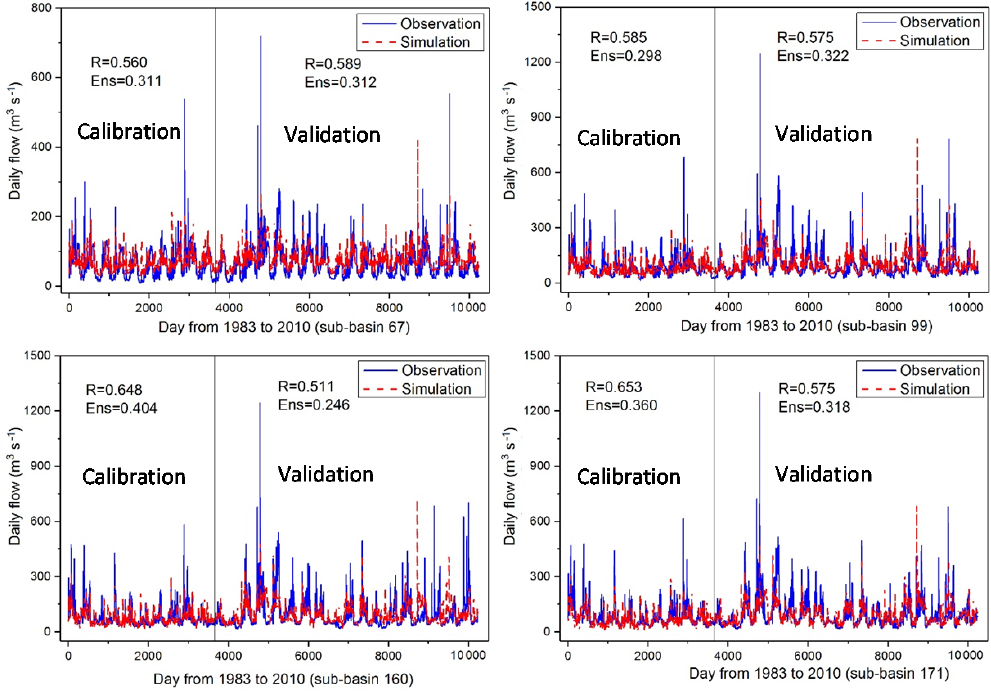
Figure 4. Calibration and validation results under the R2 scenario (RiverWare for reservoir operations).